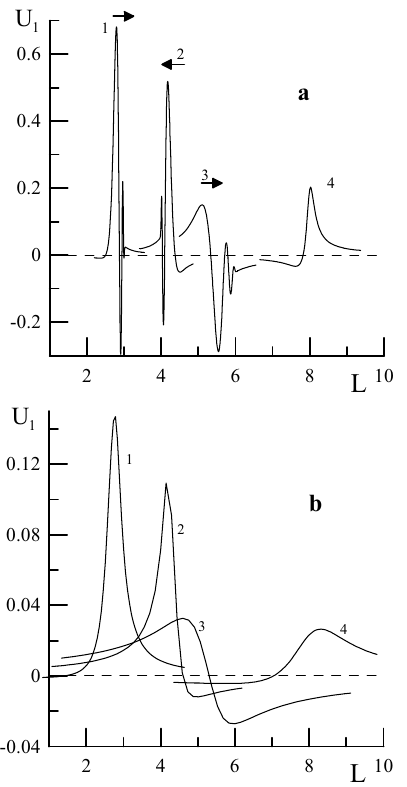
Fig.8. Thetransverse structure of the first longitudinal harmonic of standing Fig. 8. The transverse structure of the first longitudinal har- Alfven waves ( ) with azimuthal wave number , excited on 4 monic of standing Alfv´en waves ( N = 1) with azimuthal wave num- N=1 m=100 different magnetic shells ( )by ionospheric external currents of L=3;4;6;8 ber m = 100, excited on 4 different magnetic shells ( L = 3 , 4 , 6 , 8) equal density. Fig.8a shows oscillations with moderate damping ( ), (cid:15)=0:1 by ionospheric external currents of equal density. (a) shows os- while Fig. 8b, those with small damping ( (cid:15)=10(cid:0)2 ). Arrows in Fig. 8b cillations with moderate damping ( (cid:15) = 0 . 1), while (b) , those with indicate the direction in which the wave propagates across magnetic shells. small damping ( (cid:15) = 10 − 2 ). Arrows in Fig. 8b indicate the direction in which the wave propagates across magnetic